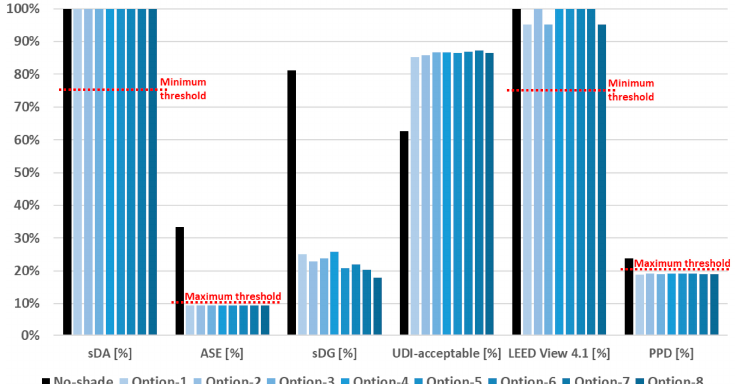
Figure 12. Comparison between no-shade penetration and eight optimum options for indoor comfort. Red lines show thresholds.